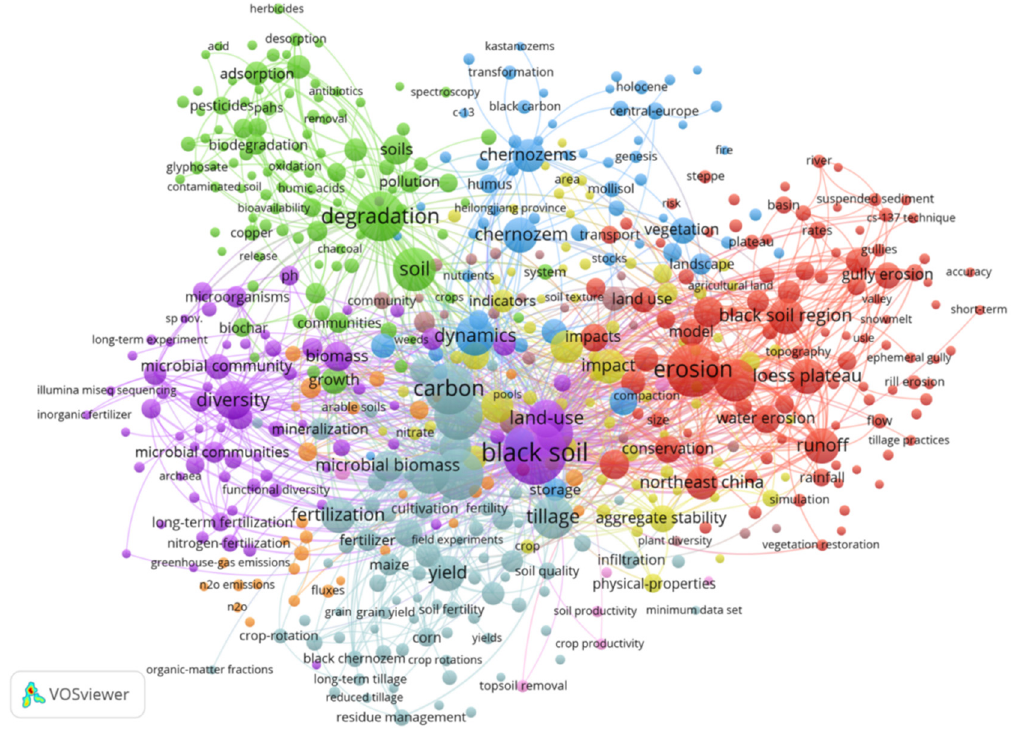
Figure 5. Clustering mapping of keyword co-occurrence networks for BSC domain publications. Table 4. Information on the top 20 keywords in terms of number of publications.